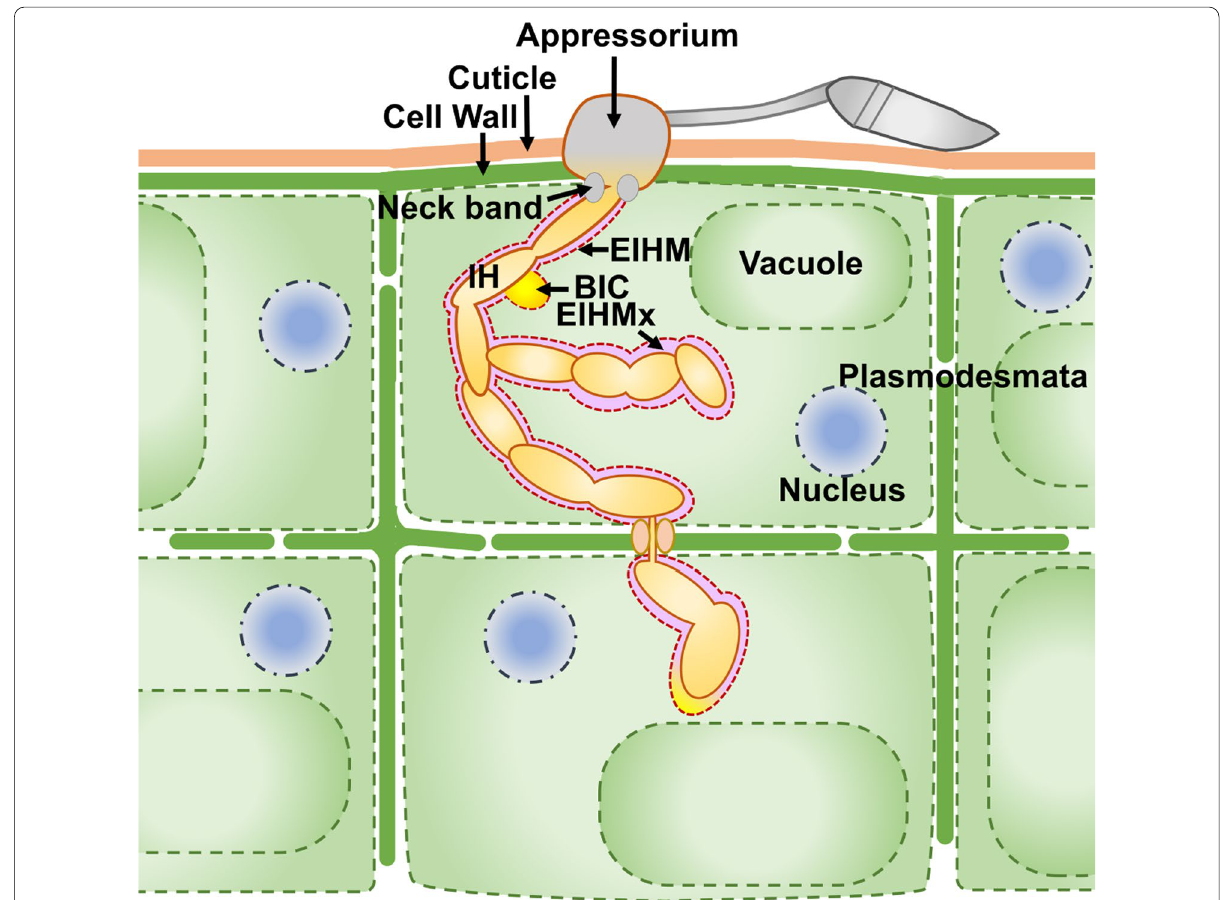
Fig. 2 The infection strategy of M. oryzae . The spore of the fungi germinates and generates an appressorium. The appressorium penetrates the barriers of cuticle and cell wall, extending the invasive hyphae (IH), invaginating the plant plasma membrane. This plant plasma membrane covering the IH is known as the extrainvasive hyphal membrane (EIHM) and the matrix between the plant and fungal plasma membranes forms the extrainvasive hyphal matrix (EIHMx). The first bulbous IH forms in the biotrophic invasion complex (BIC), which is the specialised region of EIHMx for fungal secretions. EIHMx forms the interface for interactions between the plant and fungi. The fungal IH continue to grow in the plant invading new cells and forming new BIC regions through